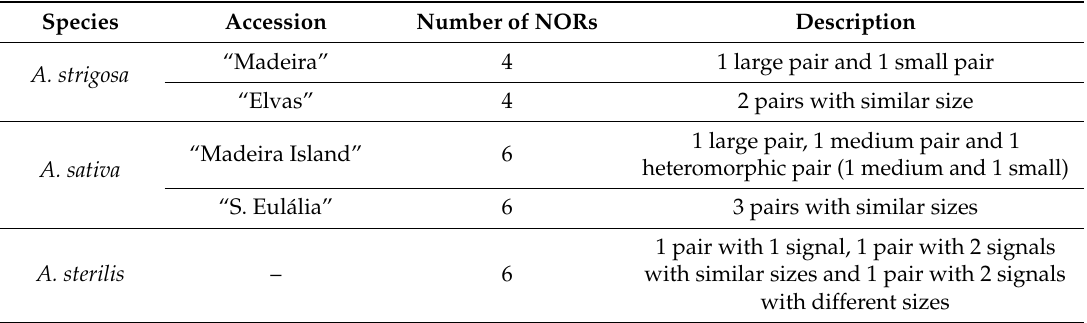
Figure 2. 45S rDNA fluorescent in situ hybridization (green signals) in metaphase cells of Avena hexaploid species. Three pairs of NORs are detected both in A. sativa as in A. sterilis . ( a ) A. sativa “S. Eulália” presenting NORs with similar sizes; ( b ) A. sativa from Madeira Island showing one large pair of NORs, one medium size pair and one heteromorphic pair (one medium size and one small); ( c ) A. sterilis showing one NOR pair with one signal (long line arrow); a second pair composed by two domains with different sizes (short line arrow); and a third one with two domains with similar sizes (arrow head). Table 2. rDNA FISH signals.